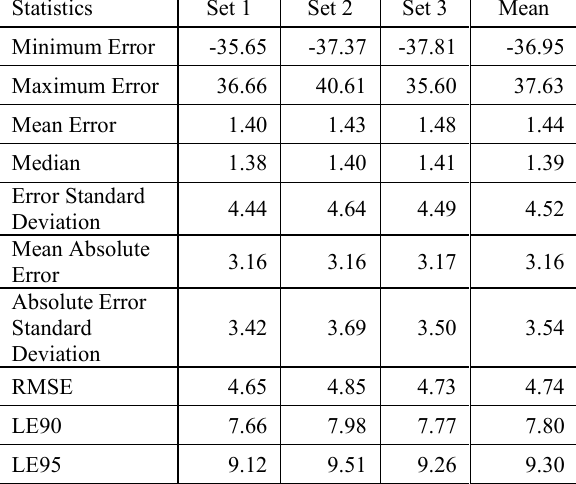
Figure 3 . Histogram of FABDEM errors over the Philippines according to the set of GCPs.